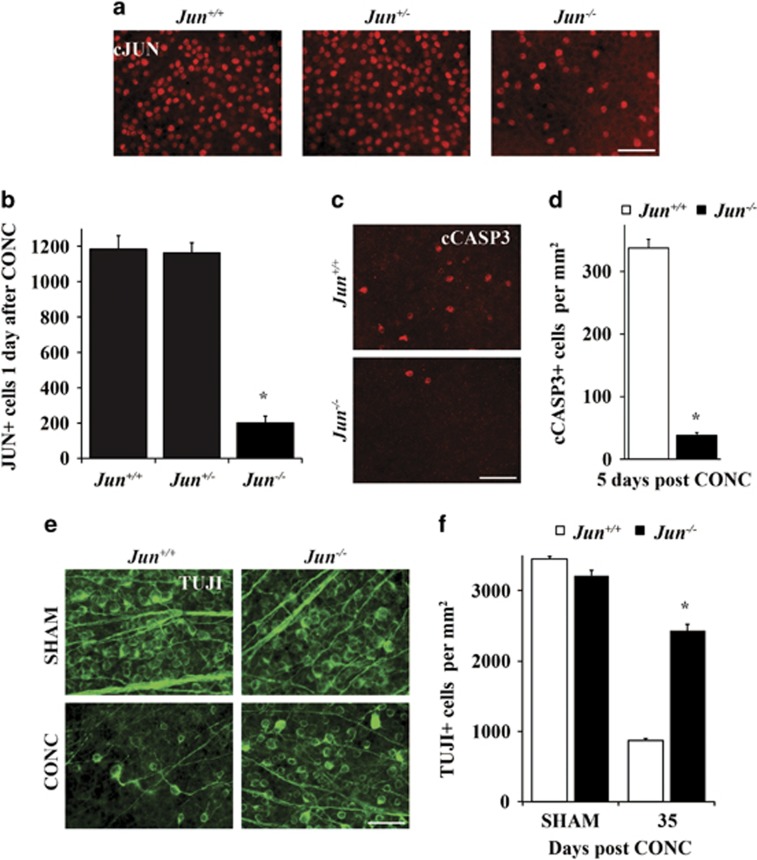
Establishing and validating Jun-deficient DBA/2J mice. (a) To determine the recombination efficiency of Six3-cre, the number of JUN+ cells were counted in retinal flat mounts 1 day after controlled optic nerve crush (CONC), a time prior to RGC death when JUN is widely expressed. (b) JUN+ cells were reduced by 83% in Jun-deficient retinas (error bars represent S.E.M.; n=6 per genotype; P<0.001; scale bar: 50 μm). To ensure genetic background did not alter the protection afforded by Jun deficiency for RGC death after axonal injury, CONC was performed in young DBA/2J animals (<5 months of age). (c, d) Similar to the protection from CONC observed on the C57BL/6J background,18
Jun-deficient animals had 88.7% fewer cleaved caspase 3+cells (cCASP3, red) as compared with control animals (P<0.001, n=6). (e, f) Jun-deficient animals had significantly greater RGC survival (TUJ1+ cells, green) than wild-type animals 35 days after CONC, a time point when the majority of RGCs will have died after CONC (WT: 25.1% survival, Jun-deficient: 75.5% survival; *, P<0.001, n=6; scale bars: 50 μm). Error bars represent S.E.M.